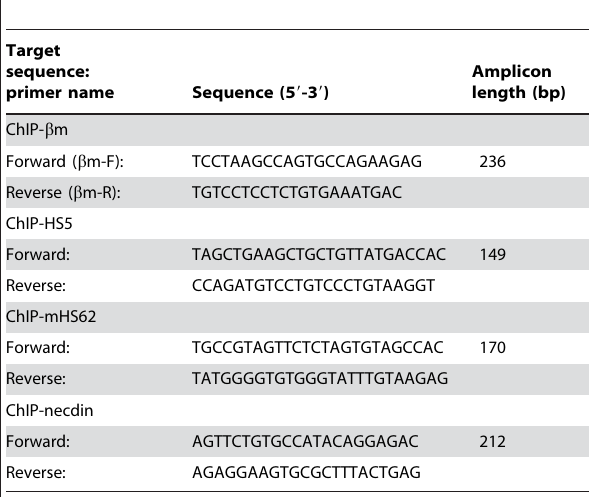
letters. The proposed CTCF binding sites in the b m sequence are indicated with red letters and the cHS4 CTCF binding sequence is shown on top of each proposed binding site. Conserved binding sequences are highlighted with a gray background. The alignment was performed with the ClustalX program (2) Reference List 1.